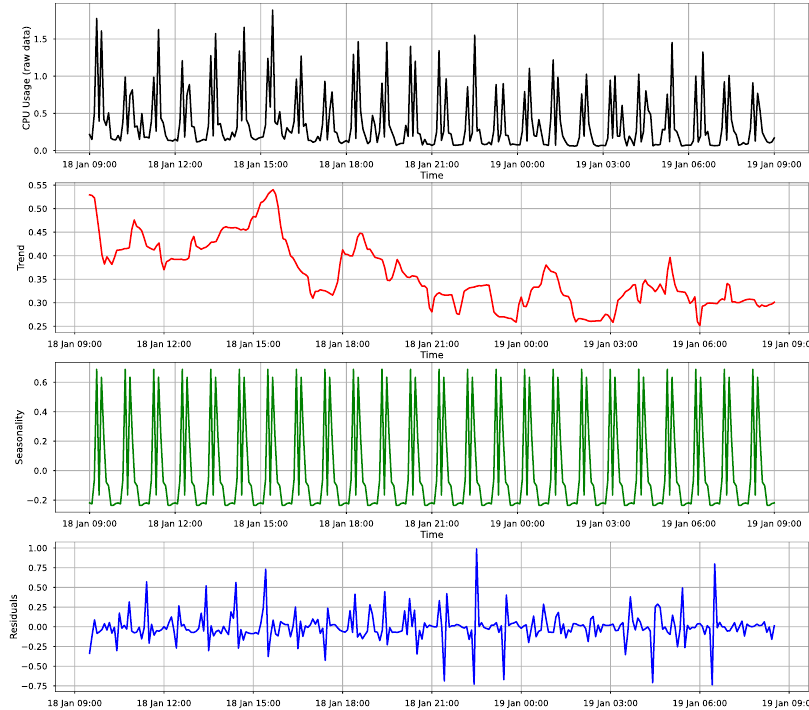
Figure 2. Decomposition (weekday).